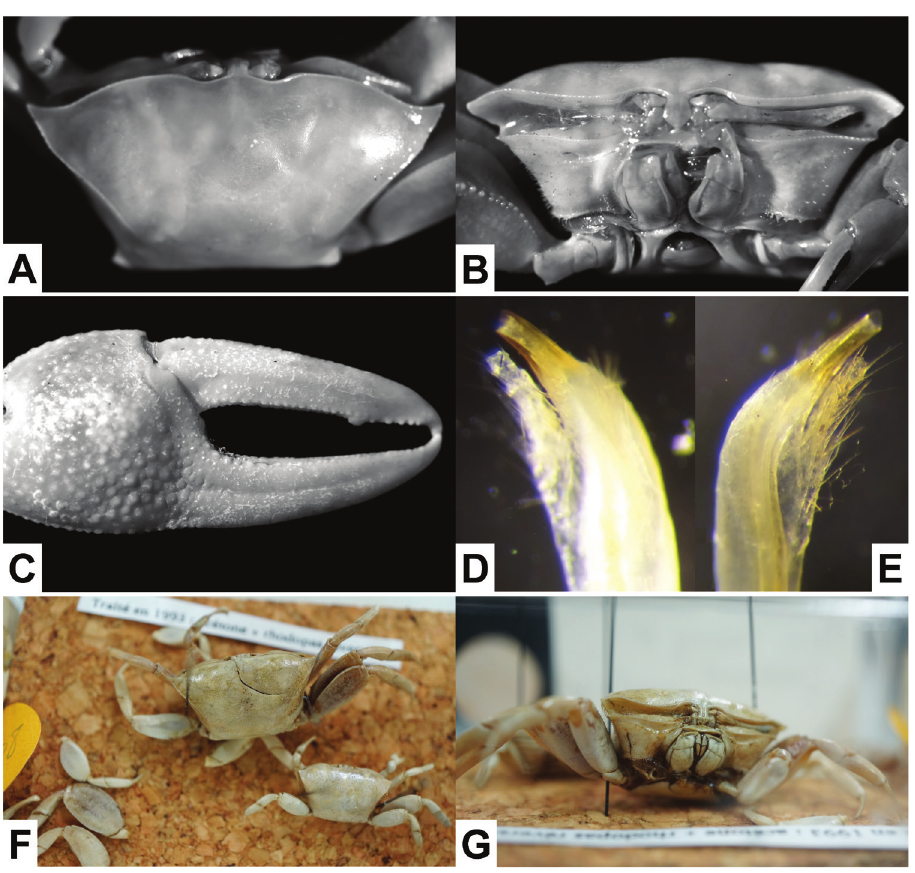
B.12073) F–G 2 dried female paralectotypes (MNHN B. 3208). A dorsal view B frontal view C major cheliped D, E distal part of right G1. D mesial view E lateral